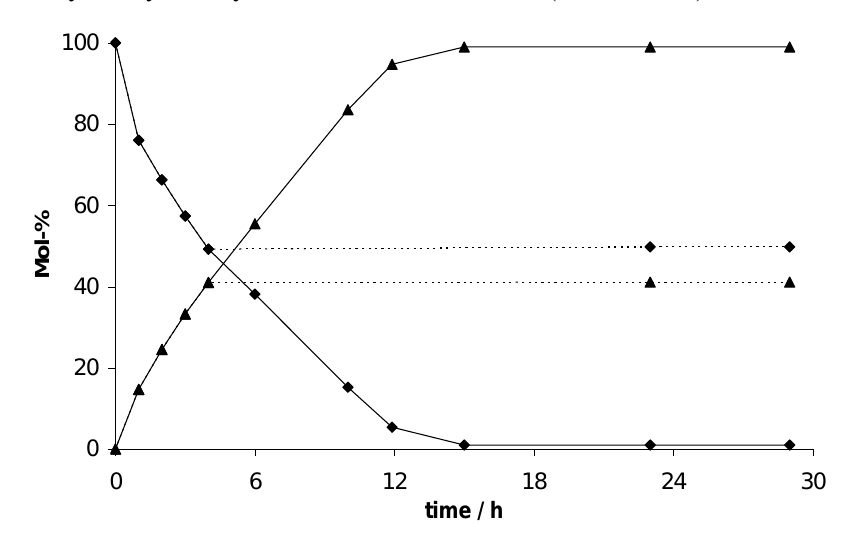
Figure 9. Consumption of benzaldehyde (diamonds) and product yield (triangles) during the EOF-5 catalyzed cyanosilylation with filtration test (dotted